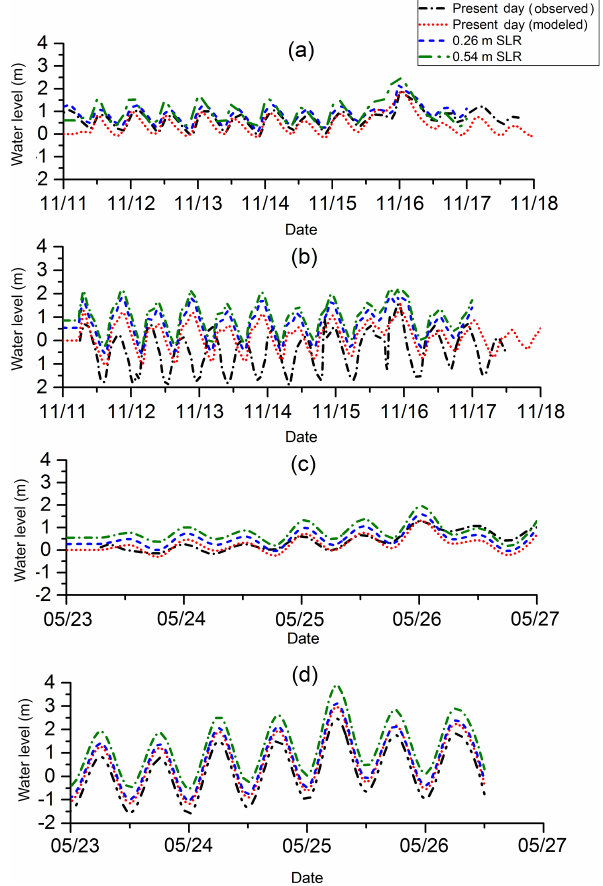
Figure 7. Comparison of storm surge water levels between present- day and future SLR scenarios. (a) TC Sidr at Barisal, (b) TC Sidr at Charchanga, (c) TC Aila at Barisal and (d) TC Aila at Charchanga. The observed, modelled present-day, mid-21st-century and end- 21st-century storm surge levels are denoted by the black dashed- dotted, red-dotted, blue-dashed and green dash-dotted